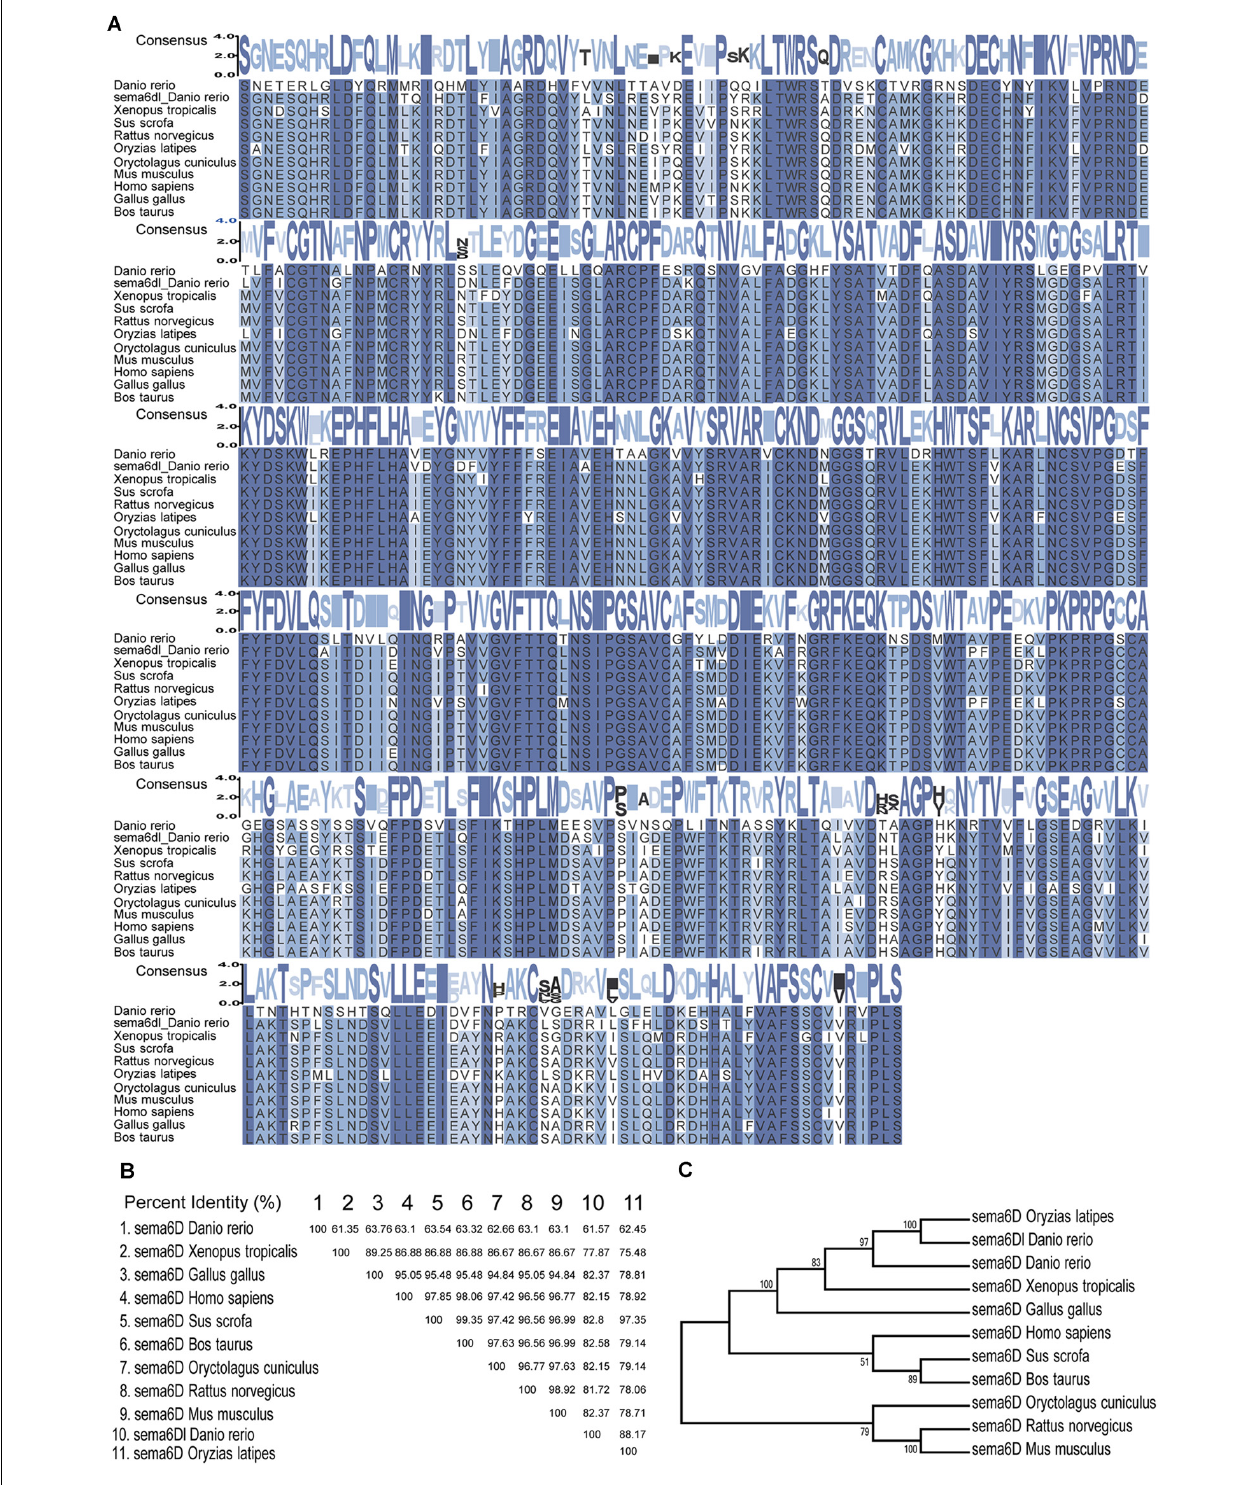
FIGURE 1 | Sema6D Is highly conserved during evolution. (A) Alignment of the amino acid sequences of the sema domain of sema6D/sema6Dl in Danio rerio , Bostaurus, Gallus gallus, Homo sapiens, Musmusculus, Oryctolaguscuniculus, Oryziaslatipes, Rattusnorvegicus, Sus scrofa, and Xenopus tropicalis . Consensus values indicate the similarity of amino acid sequence, and the greater the similarity. These protein sequences were aligned using MEGA7 software and edited by TBtools. (B) The amino acid sequence similarity (%) of sema domain in above species. (C) Phylogenetic tree of the sema6D protein.